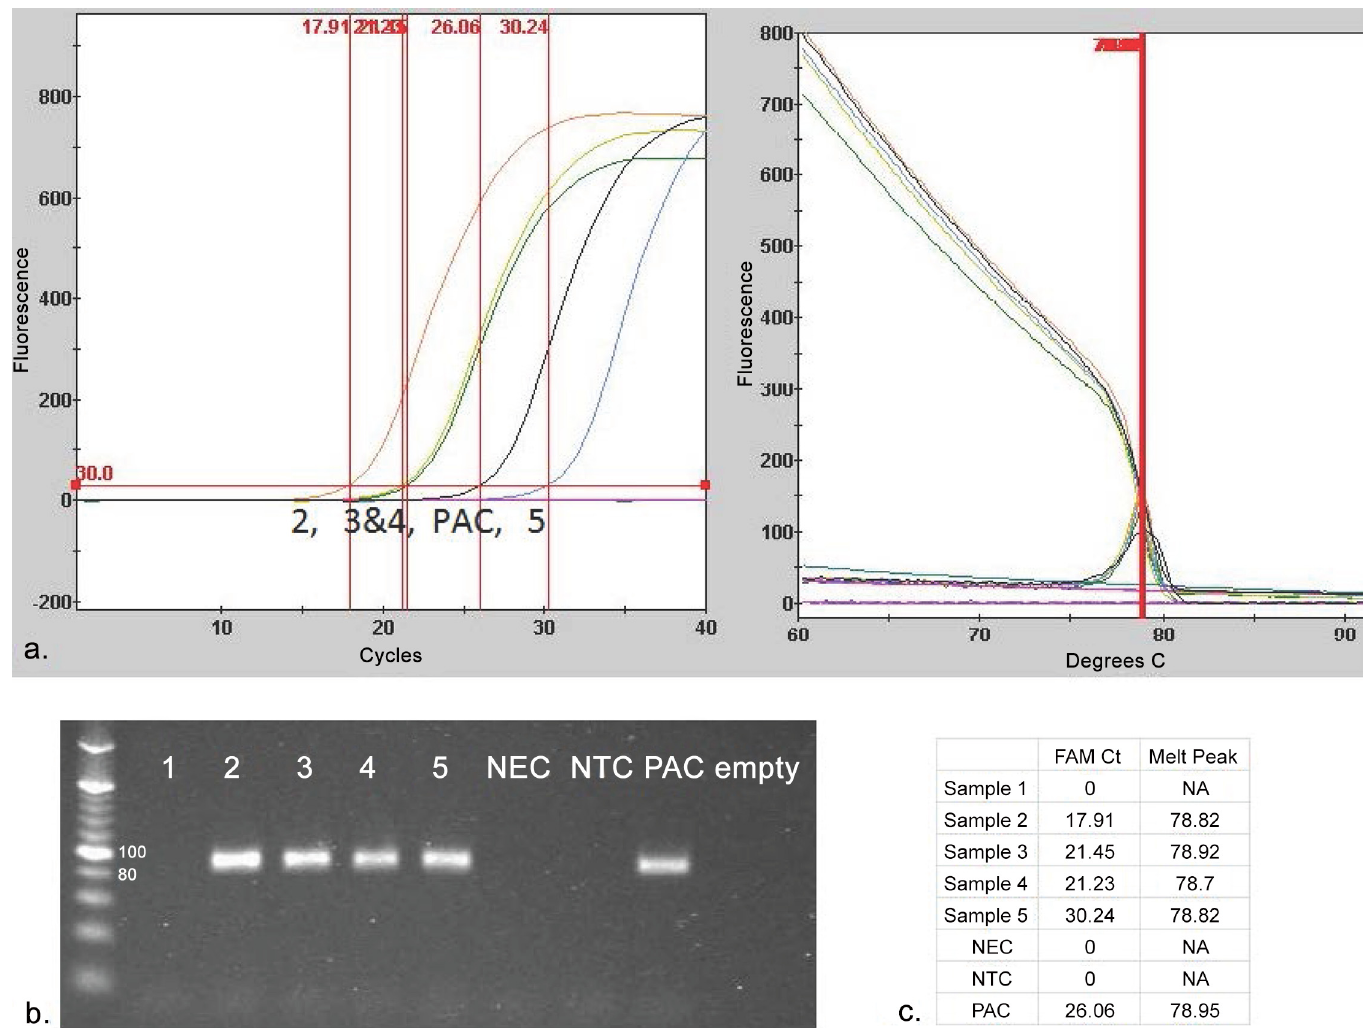
Fig 3. RT-qPCR data with amplicons visualized by DNA gel electrophoresis. Five diagnostic RNA samples with three controls were analyzed by RT- qPCR on the SmartCyclerII. (a) Ct and melt curves are displayed. (b) All products were subjected to high resolution gel electrophoresis to verify amplification of specific products of ~90bp. Control samples included a negative extraction (NEC), a negative template (NTC) and a positive amplification (PAC) control. (c) Ct values and melting temperature data is summarized.